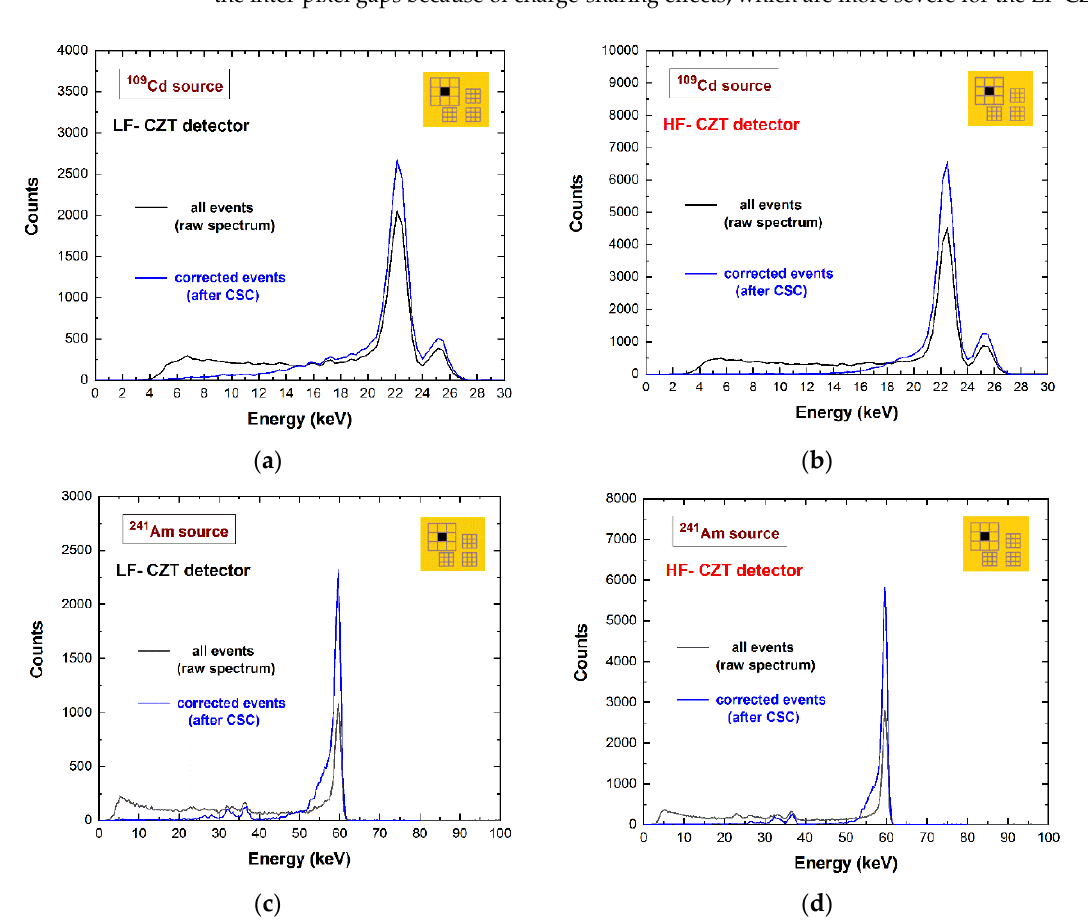
Figure 9. Spectroscopic results after the correction of the charge-sharing and fluorescence crosstalk events (after CSC). The raw energy spectra (black lines) and the corrected spectra (blue lines) for ( a ), ( c ) the LF-CZT and ( b ), ( d ) HF-CZT detectors are shown. The energy resolution of the HF-CZT detector was slightly improved after correction.